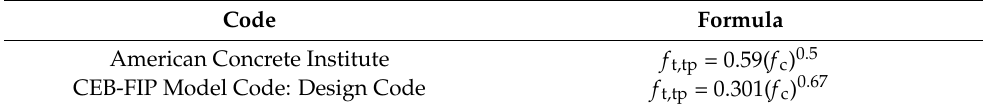
Figure 7. Relationship between splitting and compressive strength of the mixture. Table 7. Formulas are suggested by the model code.